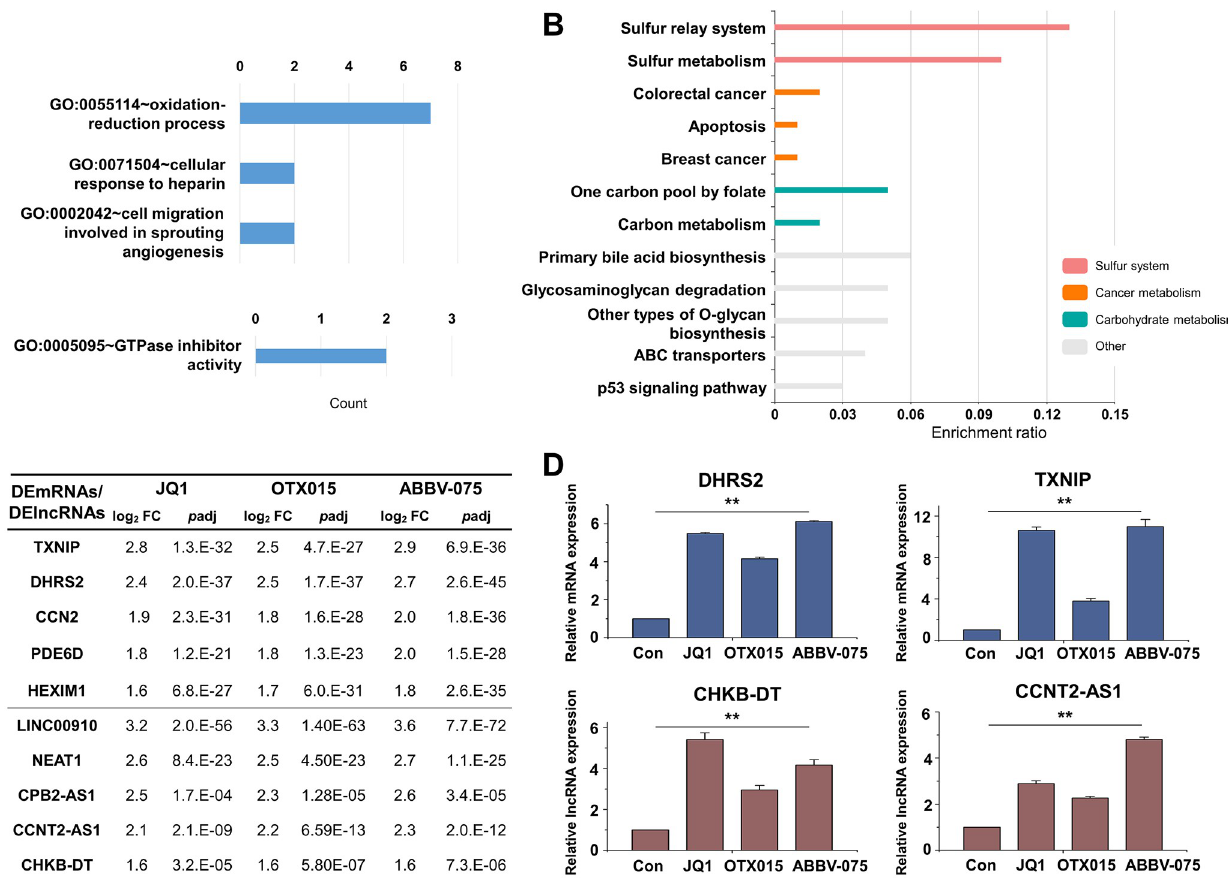
Fig 9. Functional analysis and confirmation of DEmRNAs and DElncRNAs in Module 2. (A) The number of genes enriched for each term are displayed for the GO terms in biological process (upper panel) and molecular function (bottom panel). (B) KEGG pathway enrichment analysis of DEmRNAs. Each row represents an enriched function, and the length of the bar represents the enrichment ratio. (C) Log 2 fold changes and p adj in the expression of genes in Module 2. (D) Expression levels of adhesion-related mRNAs and lncRNAs were analyzed by qRT-PCR and normalized to GAPDH or U6 transcript levels, respectively. Overall, the expressions of adhesion-related mRNAs and lncRNAs were increased by BET inhibitor. The data represent three independent experiments. The values are the mean ± SD of triplicate experiments ( �� p < 0.01).